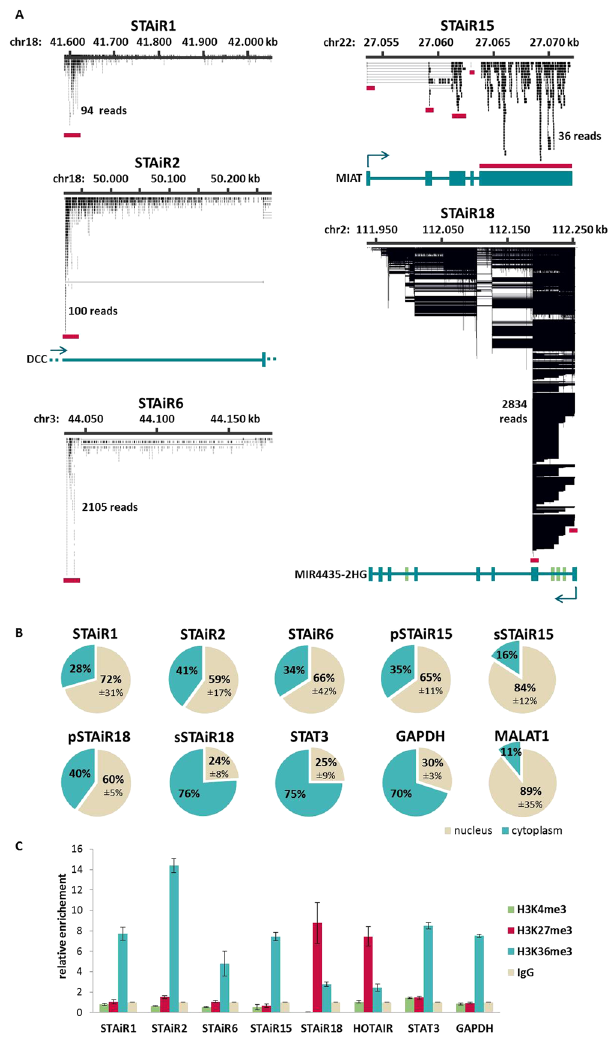
Figure 2. Processing, subcellular localization and chromatin association of STAiRs. ( A ) CAPTURE-RNA- sequencing was performed using 12 biotinylated oligonucleotides per STAiR target RNA (STAiRs 1, 2, 6, 15, 18) and 6 oligos for bacterial lacZ as a negative control. The pulldown was performed with RNA from permanently IL-6 stimulated (10 ng/ml) INA-6 cells. The RNA pulldown was implemented by streptavidin beads, following an RNA preparation, DNase digestion, library preparation (Scriptseq, Epicenter), and subsequent NGS. Identified reads were mapped to the human genome hg19. The resulting transcription patterns were visualized using Integrative Genome Viewer (IGV). The regions of oligo binding are marked with red lines below. For STAiRs 15 and 18 the annotated ncRNAs are shown in blue at the bottom. For STAiR18, 4 novel exons were identified shown in green. ( B ) Subcellular localization of STAiRs. Nuclear-cytoplasmic fractioning was performed with permanently IL-6-treated INA-6 cells. RNA was prepared, DNase-digested, reverse transcribed and relative gene expression determined by qPCR. For unspliced STAiRs 1, 2 and 6, the used primers detect primary transcripts, whereas for spliced STAiRs 15 and 18, both a pair detecting the primary (p) and spliced (s) transcript were applied. Primer pairs for STAT3 and GAPDH are intron-spanning. For detection of infrequently spliced MALAT1 a pair of exonic primers was used. Values were normalized to the corresponding cytoplasmic fraction. Means ± SD (in %) of STAiR expression per fraction are shown (n ≥ 3). ( C ) Chromatin association of STAiRs. RNA immunoprecipitation was performed with permanently IL-6-treated INA-6 cells using antibodies targeting H3K36me3, H3K4me3, and H3K27me3 as well as IgG as a negative control. RNA was prepared, DNase-digested, and reverse transcribed. RNA enrichment was analyzed by qPCR using intron-spanning primers (STAT3, GAPDH) and primers detecting the primary, unspliced ncRNA transcripts (STAiRs and HOTAIR). Samples were normalized to the IgG control. Means ± SD of STAiR enrichment per IP are shown (n ≥